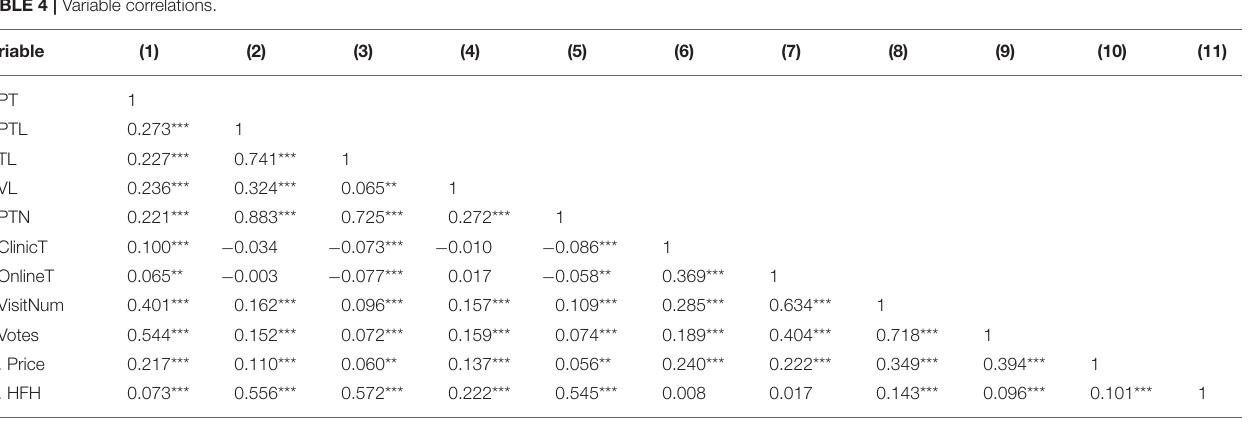
TABLE 4 | Variable